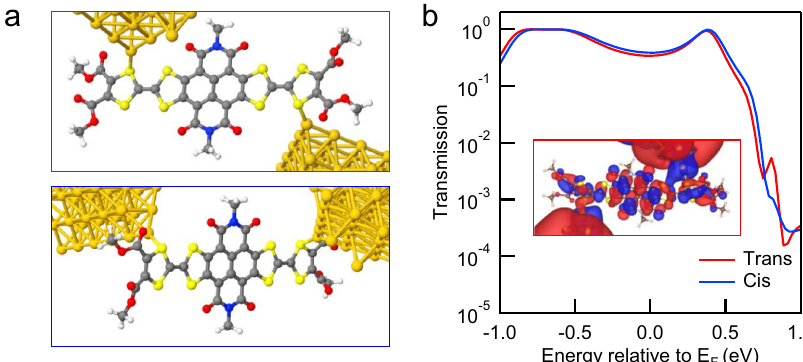
Fig. 3 DFT-based transmission calculations of NDITTF-MF. a Junction structures used to compute the junction transmission functions. b Transmission functions against energy of the two types of junctions. Inset: Eigenstate at the Fermi energy for the junction in a trans